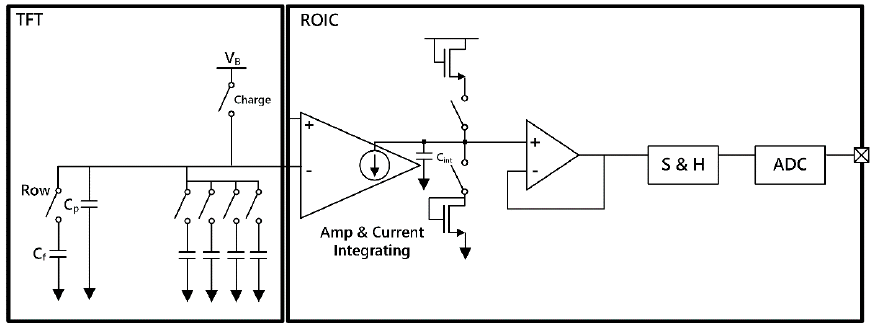
Figure 7. A pixel equivalent circuit model and a single channel analog front end (AFE) of fingerprint senor system.